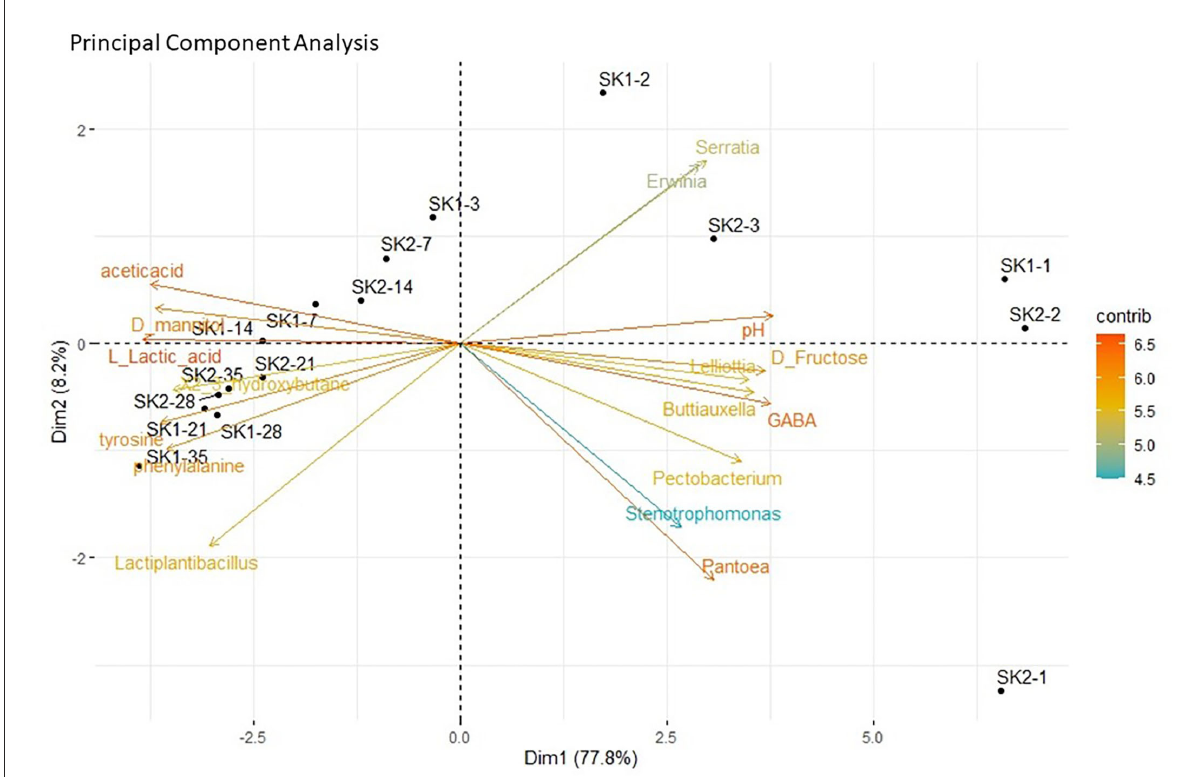
FIGURE4 Principal component analysis (PCA) biplot showing correlations between bacterial genera and metabolites at different stages of sauerkraut fermentation. Bacterial genera and metabolites which are spatially together in the same direction along an axis suggest positive correlations; metabolites and genera located in different directions indicate no correlations. The strength of the correlation is shown by the increasing distance from the center of the plot.